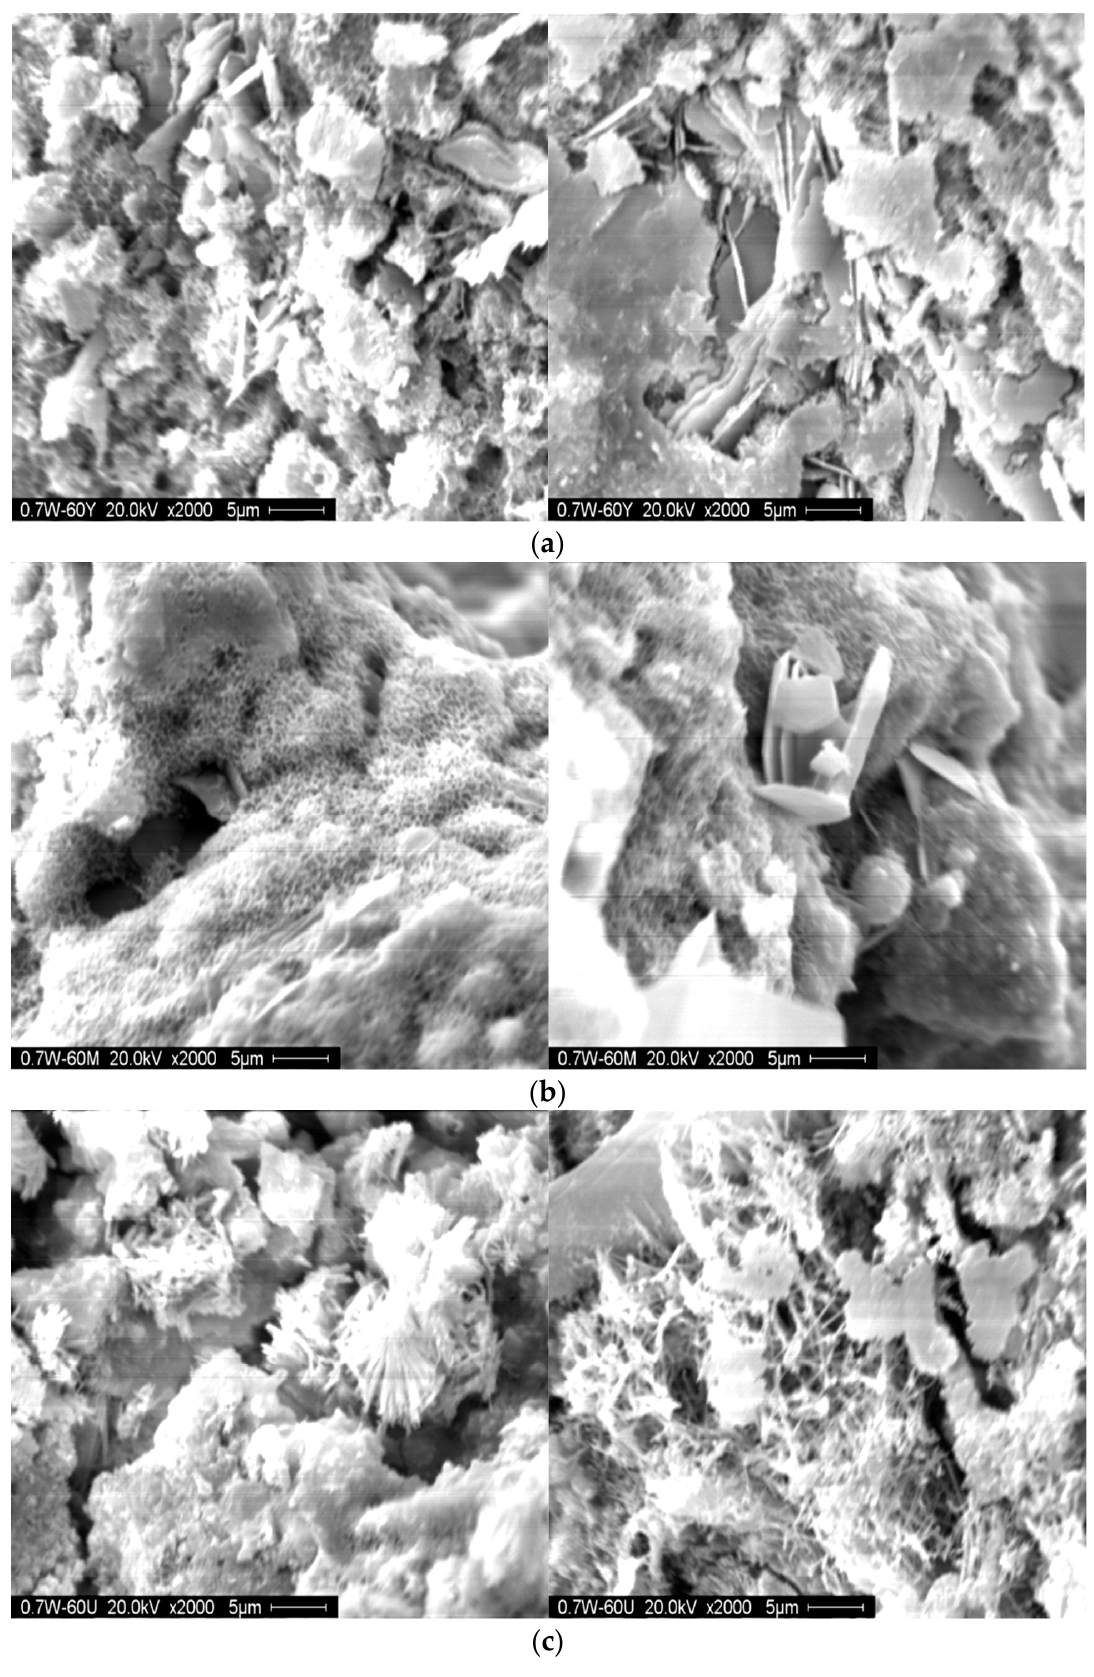
Figure 9. SEM photos of B60 specimens at different zones. ( a ) PA ( b ) PM ( c ) PC.